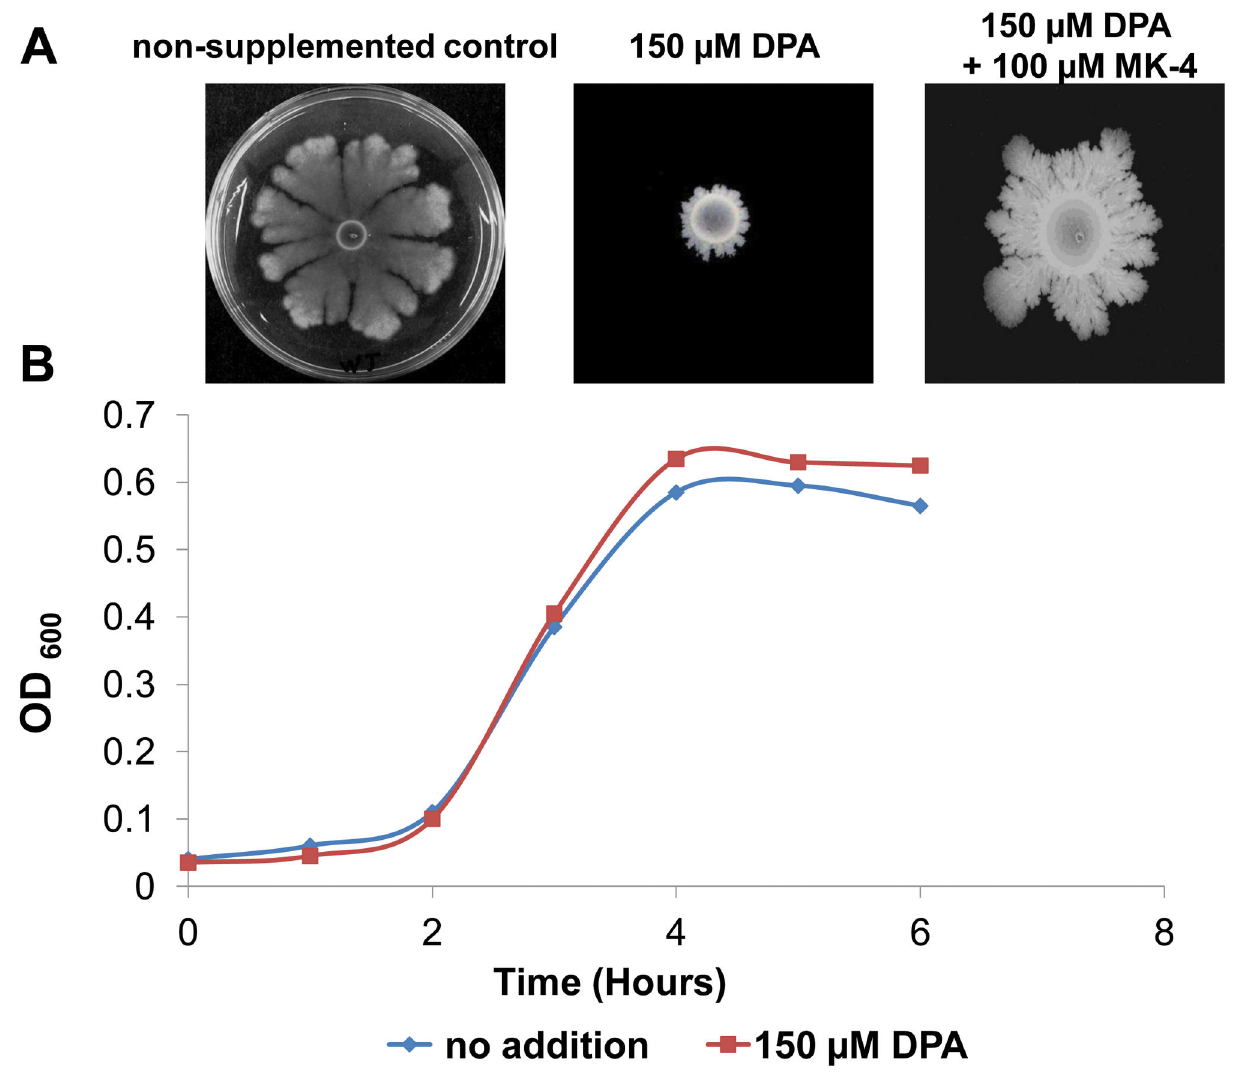
Figure 2. Menaquinone is essential for complex colony development and growth of Bacillus subtilis . A . Three μl of a fresh overnight culture of the wild-type strain were spotted onto the center of plates containing 1.2% agar supplemented with 150 µM DPA (left) or with 150 µM DPA + 100 µM MK-4 (right). Plates were photographed after 72 hours. Each experiment was carried out in triplicate. B . Growth curves of B. subtilis 3610 in spreading medium, and in spreading medium supplemented with 150 µM DPA. Each growth experiment was carried out in